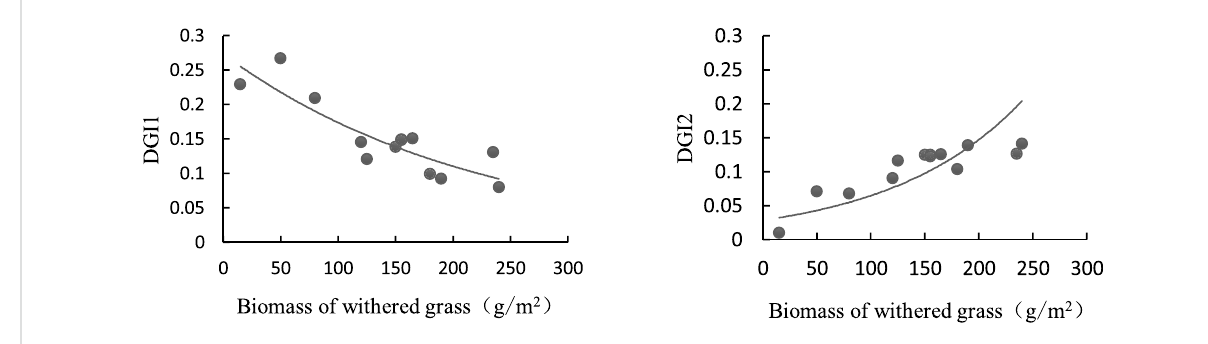
FIGURE 3 Correlations between the fi eld-measured AGB data and the DGI index.